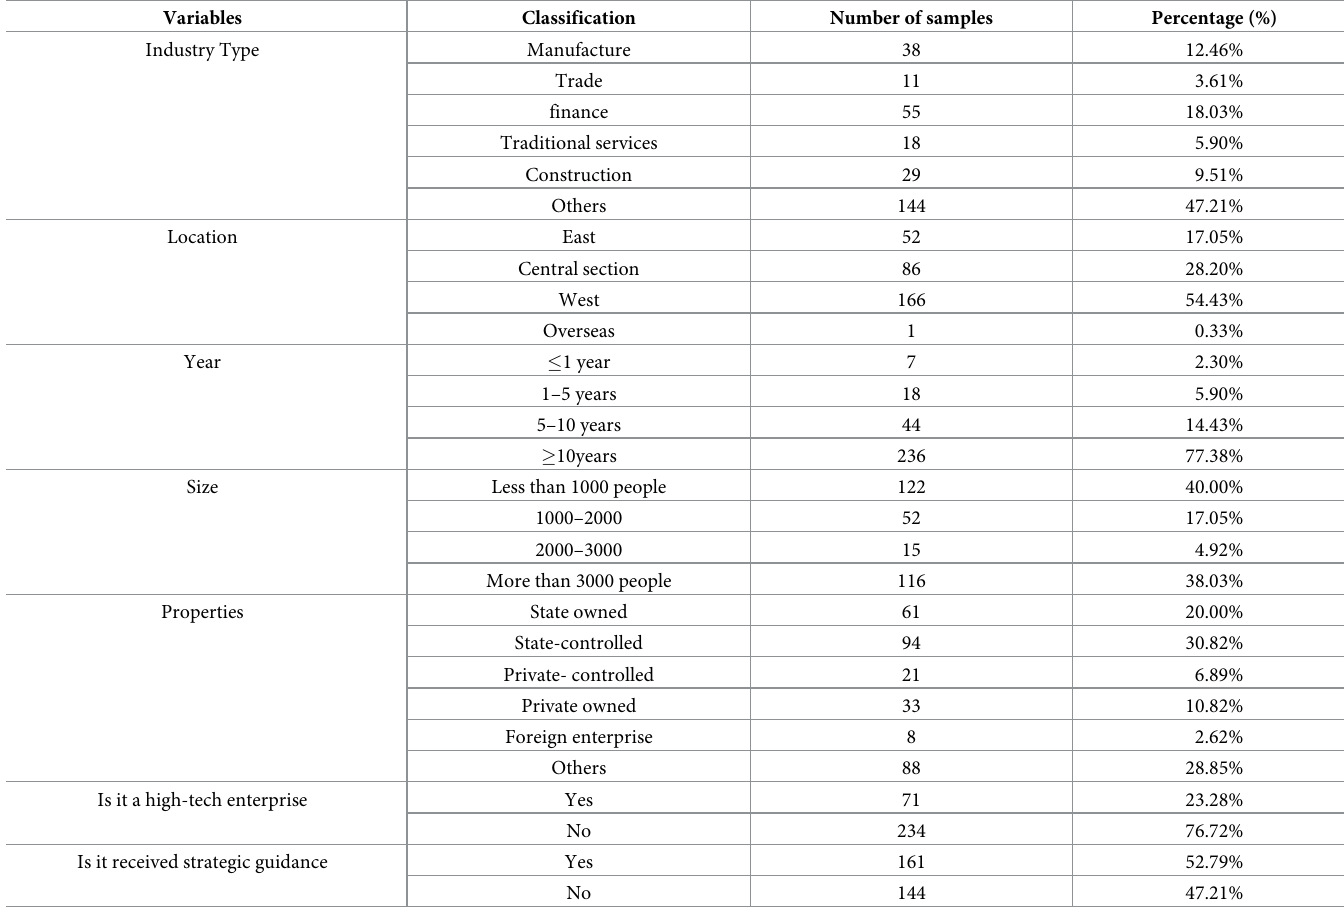
Table 2. The situation of sample